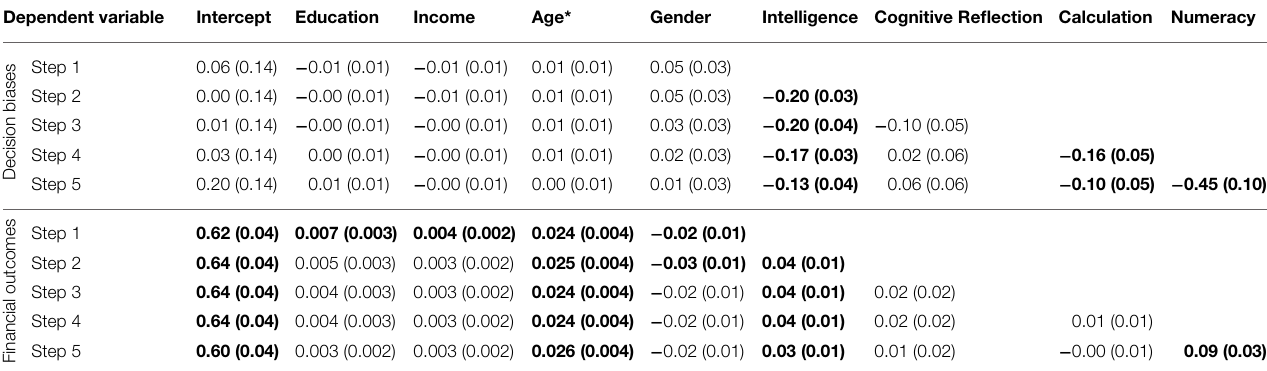
Table A2 | Robust regression results from Study 2 (see Table 8 for linear regression